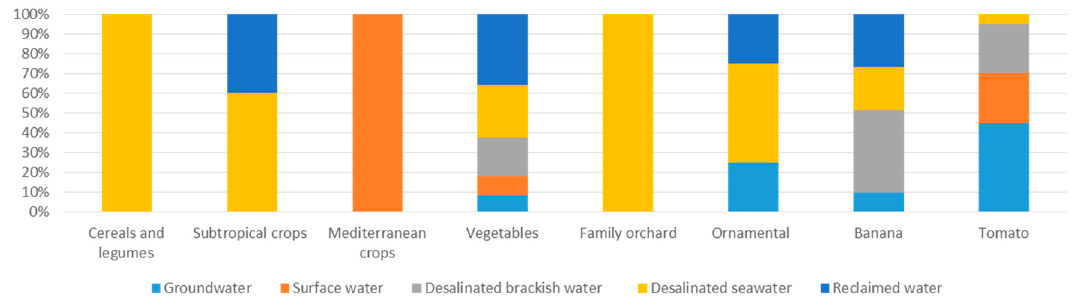
Figure 6. Typology of water resources used per crops in farms of the study area (% per farms). Water 2020 , 12 , x FOR PEER REVIEW